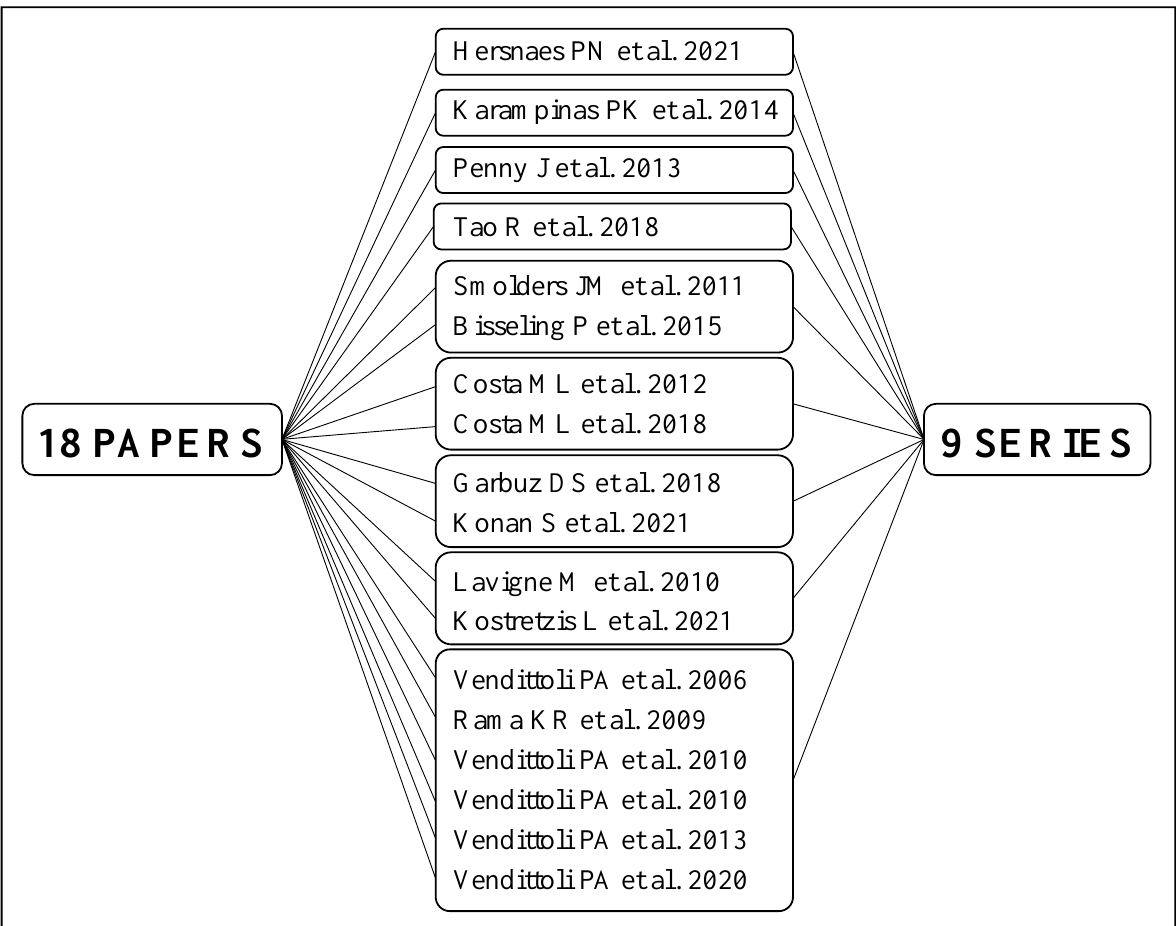
Figure 3. Correspondence between the 18 articles retrieved and the 9 series of patients treated [15 – 32]. Table 1. Characteristics and technical aspects of eligible studies.